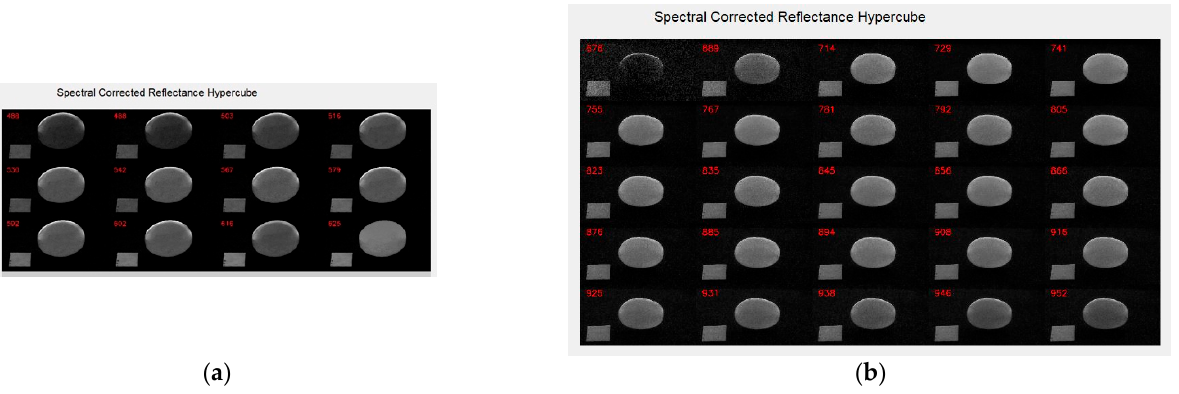
Figure 6. Configuration of the dark chamber for capturing grape images: ( a ) visible and ( b ) IR. Figure 7a,b show the 12 VIS images and 25 IR images, respectively, calibrated using Equation (1) for the grape variety Itum5.